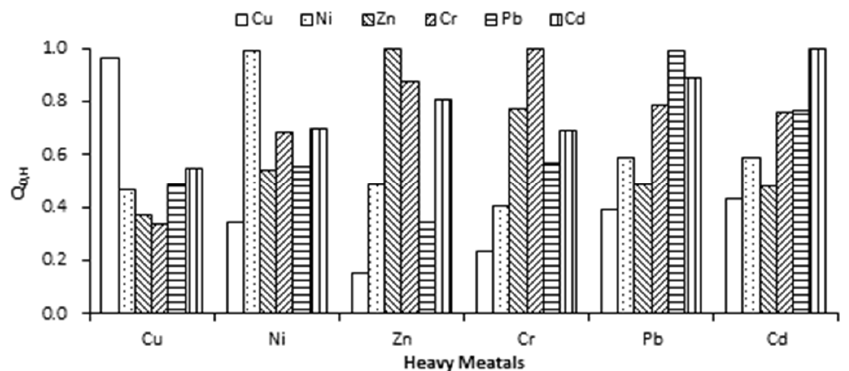
Figure 5. Spatial distribution of heavy metal influencing factor ( a ) pH, ( b ) EC, ( c ) VC, ( d ) TOC, ( e ) DEM, ( f ) ST, ( g ) PI, ( h )